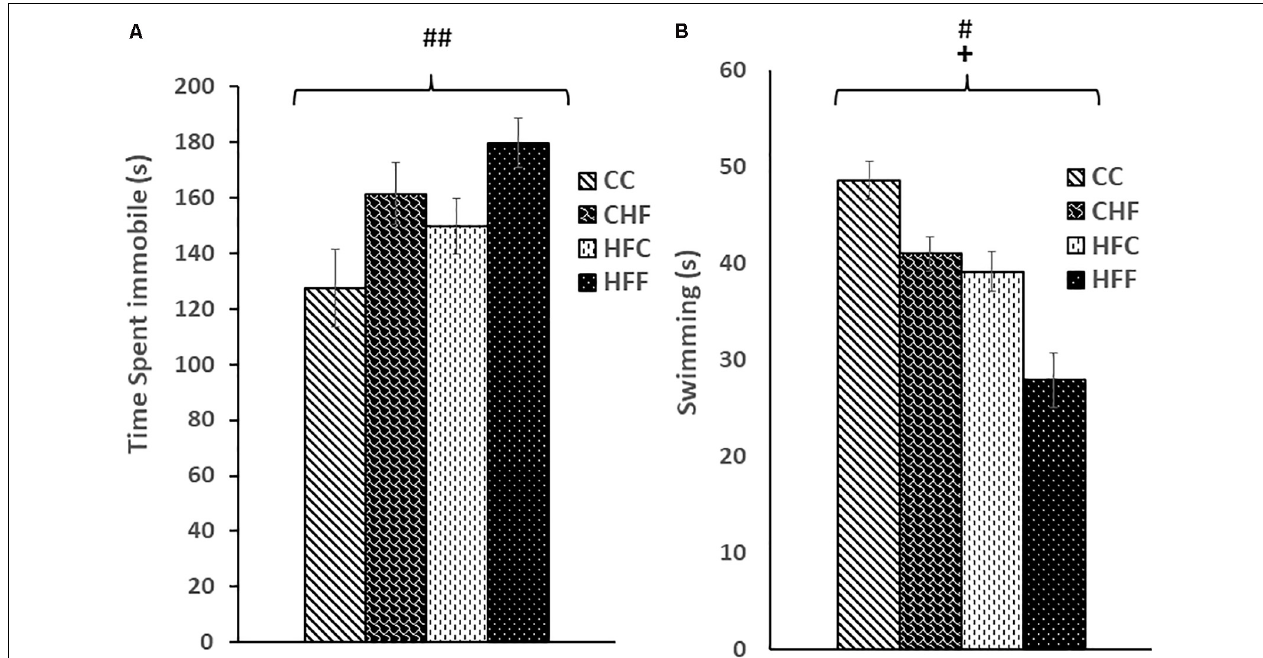
FIGURE 1 | Forced Swim Test performance was measured in adult male rat offspring from chow-fed dams or high-fat fed dams fed either chow or high-fat food post-weaning: control offspring fed chow (CC), control offspring fed high-fat food (CHF), high-fat offspring fed chow (HFC), and high-fat offspring fed high-fat food (HFF). (A) Total immobility increased significantly in response to the post-weaning high-fat diet (post-weaning diet effect: F ( 3 , 61 ) = 6.58, P = 0.01). Increased immobility in response to a maternal high-fat diet did not reach significance (maternal diet effect: F ( 3 , 61 ) = 4.15, P = 0.058). (B) Swim time was reduced by both the maternal (maternal diet effect: F ( 3 , 61 ) = 4.36, P = 0.038) and post-weaning high-fat diet (post-weaning diet effect: F ( 3 , 61 ) = 5.61, P = 0.024). No significant interactions were detected using two-way ANOVA. Values are means + SEM where n = 16 for each group. + P < 0.05 (significant maternal diet effect); # P < 0.05, ## P < 0.01 (significant post-weaning diet